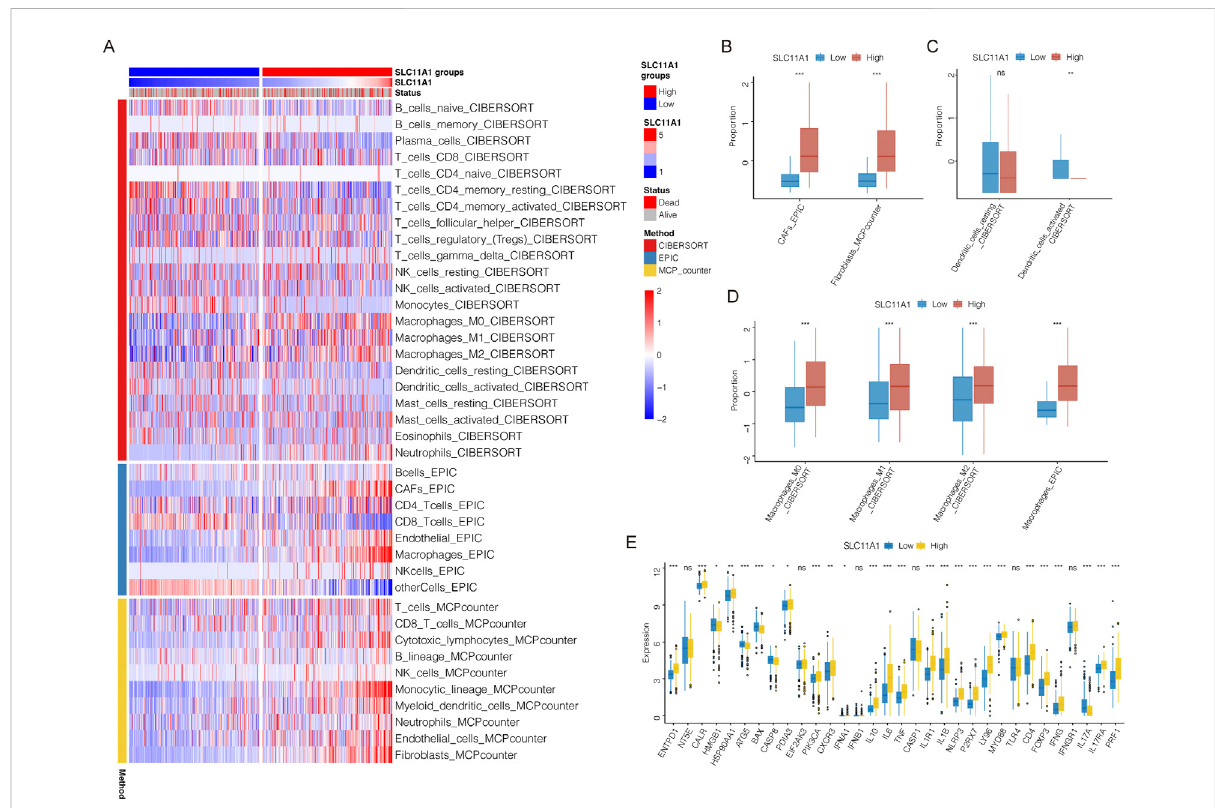
FIGURE 5 TME landscape in the low/high-SLC11A1 groups. (A) The heatmap showed the in fi ltration of immune and stromal cells. (B – D) Difference analyses ofin fi ltration levels of CAFs, fi broblasts, dendritic cells and macrophagesbetweenthelow/high-SLC11A1groups. (E) Expression differences of ICD-related genes between the low/high-SLC11A1 groups. Statistical difference was compared by the Wilcoxon